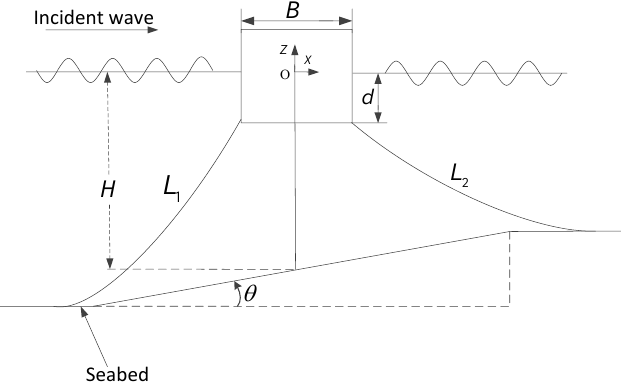
Figure 13. Profile of asymmetrical seabed with mooring lines positioned in water depth H = 20